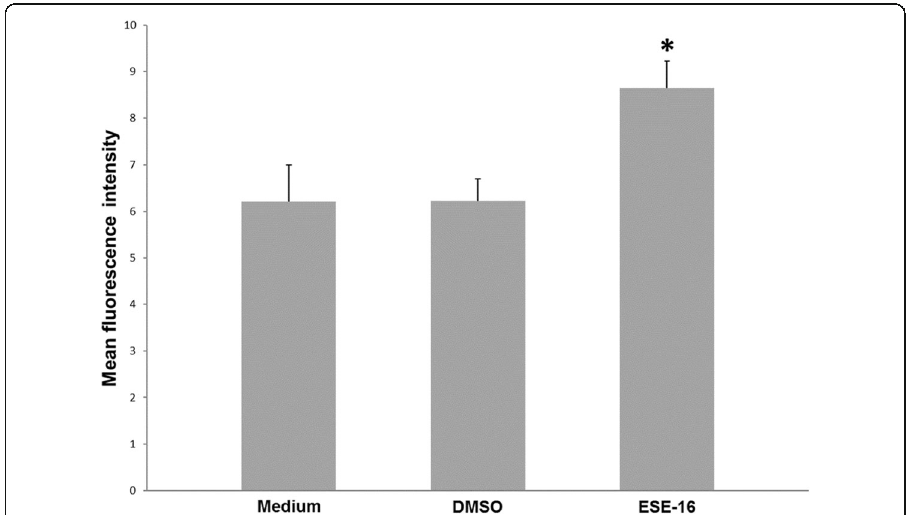
Fig. 11 Bar graph of the average mean fluorescence intensity measured for the upregulation of cyclin B1 proteins after HeLa cell exposure to ESE-16. The increase in the MFI indicates cyclin B1 upregulation compared to cells in growth medium and the vehicle-treated control cells. * p <